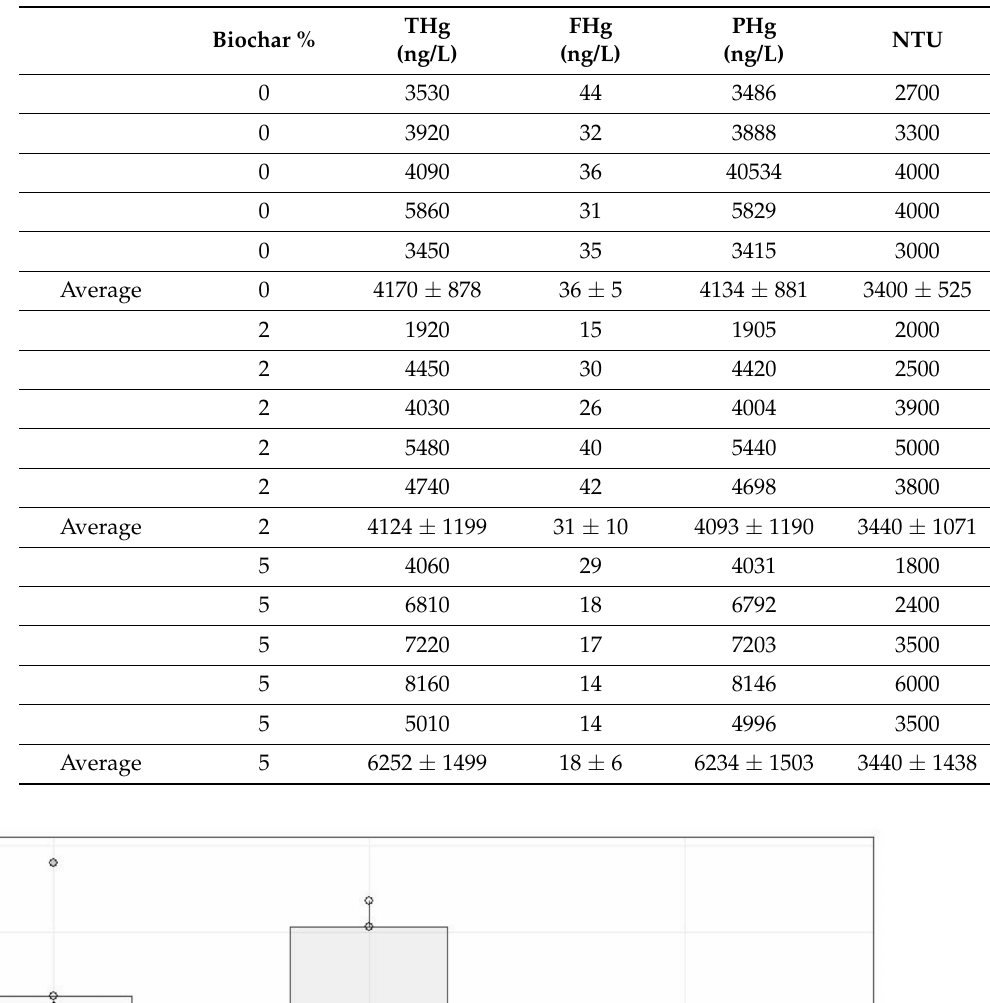
Table 2. Sediment mesocosm runoff, which was analyzed for total (THg), filtered (FHg), and particulate-bound (PHg) mercury immediately after leaching.